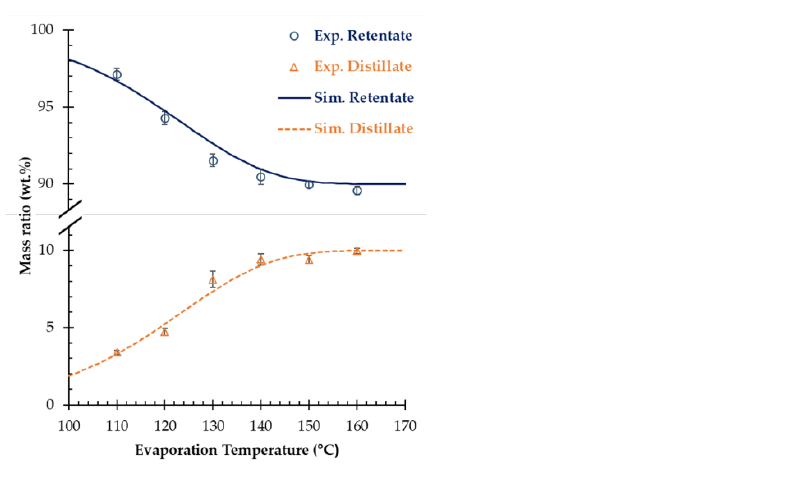
Figure 7. A comparison of mass ratio of retentate and distillate (wt.%) between experiment and simulation under condition of 10 wt.% FFA added to feeding mixture.